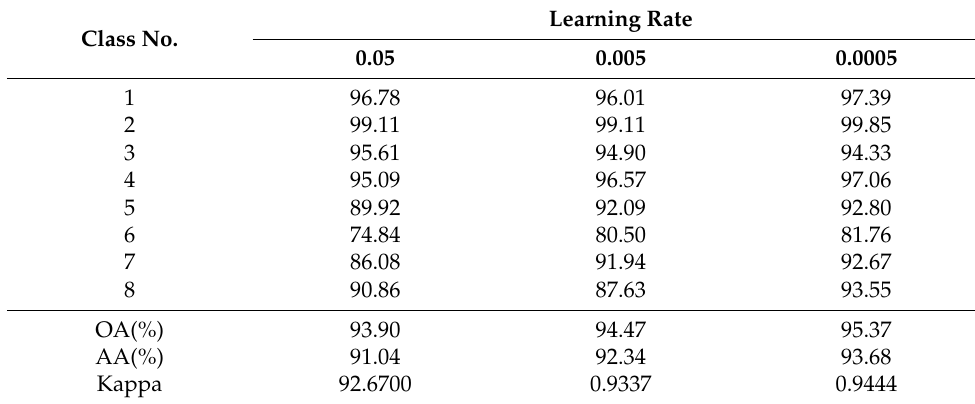
Table 3. Test set results for the study area at different learning rates. Class